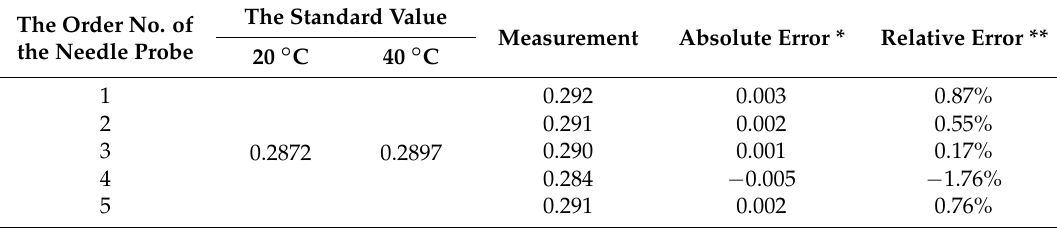
* The measurement—the average of the two standard values at 20 and 40 °C; ** the absolute error/the average of the two standard values at 20 and 40 °C.